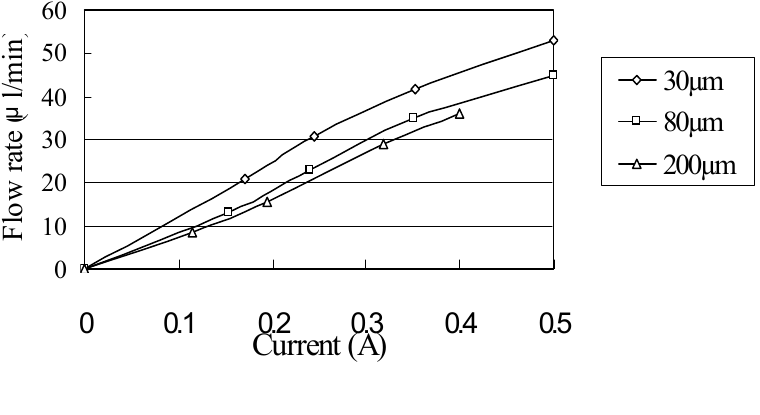
Figure 10. Variation of maximum diaphragm deflection with input current as function of PDMS diaphragm thickness at constant actuation frequency of 240